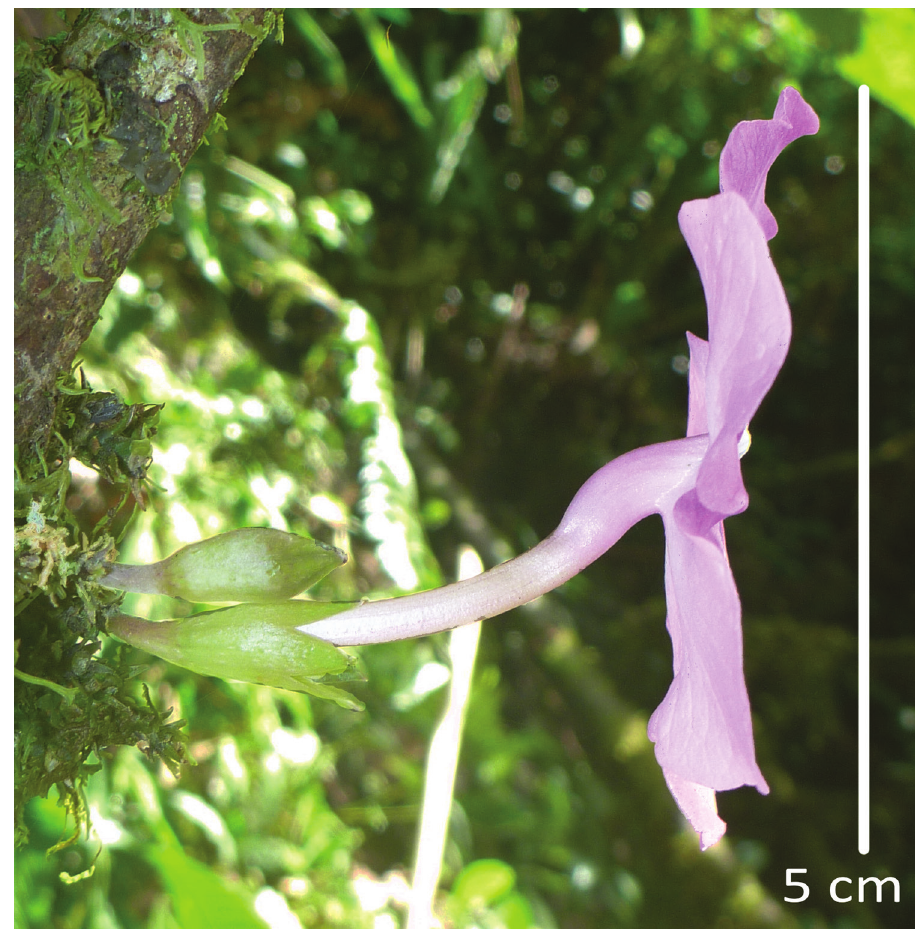
Figure 5. Profile of a flower of Brunfelsia cabiesesiana at